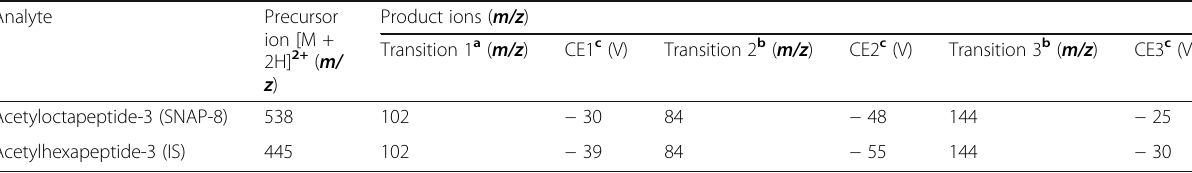
Table 2 Ion transitions and collision energy values of SNAP-8 and IS Analyte